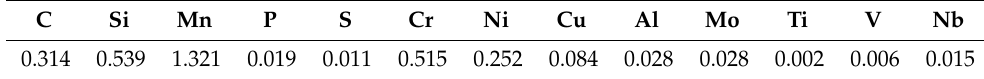
Table 1. Chemical composition of the alloy steel